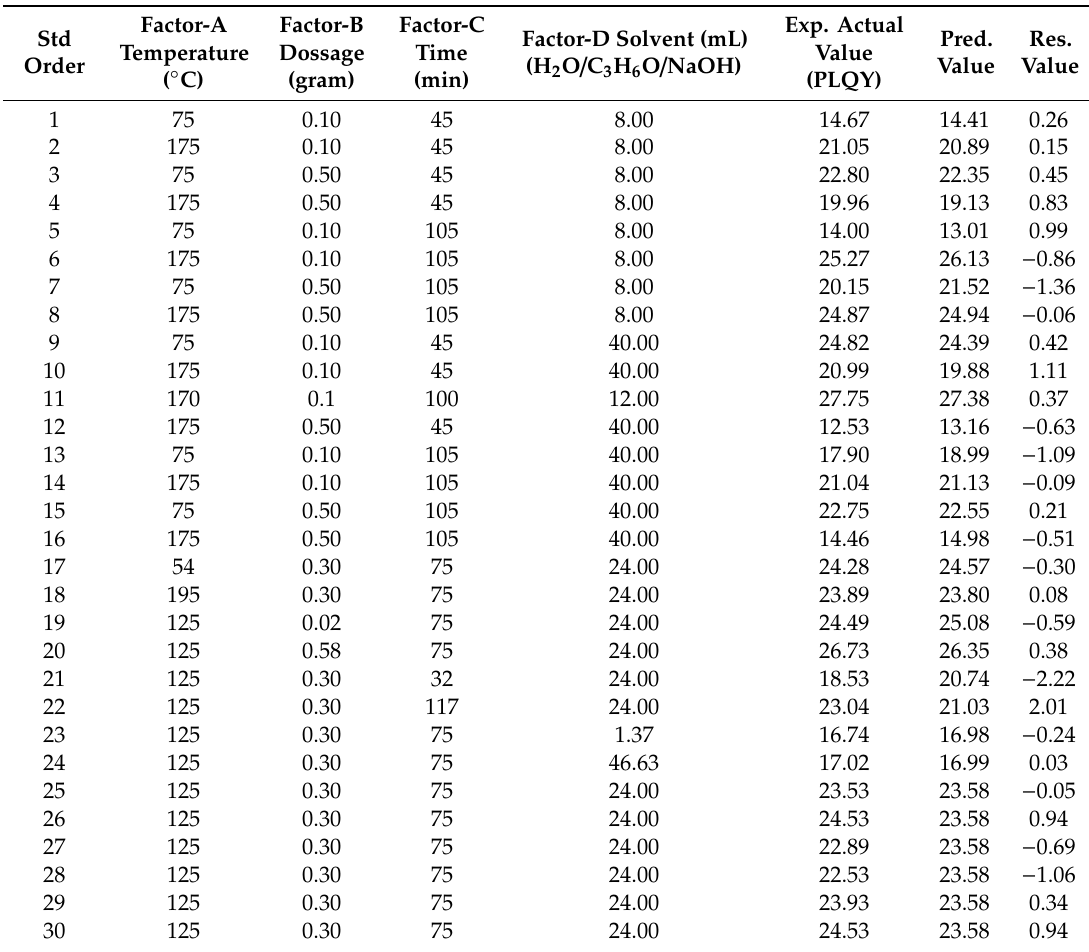
Table 2. Design of experiment for response surface methodology